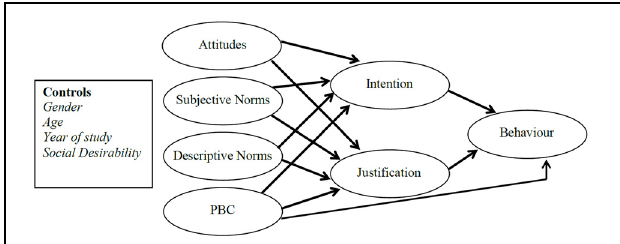
FIGURE 1 | Model of theory of planned behavior augmented by descriptive norms and